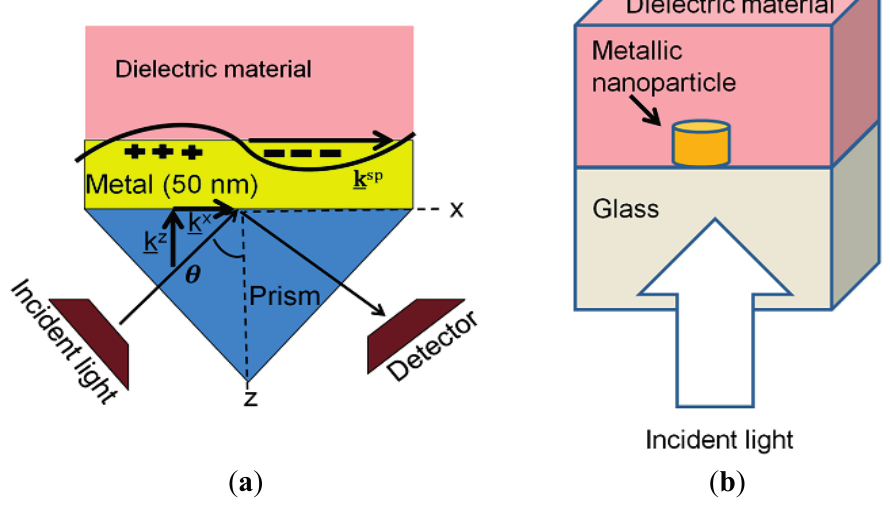
Figure 5. Demonstration of the principle of ( a ) SPR and ( b ) LSPR